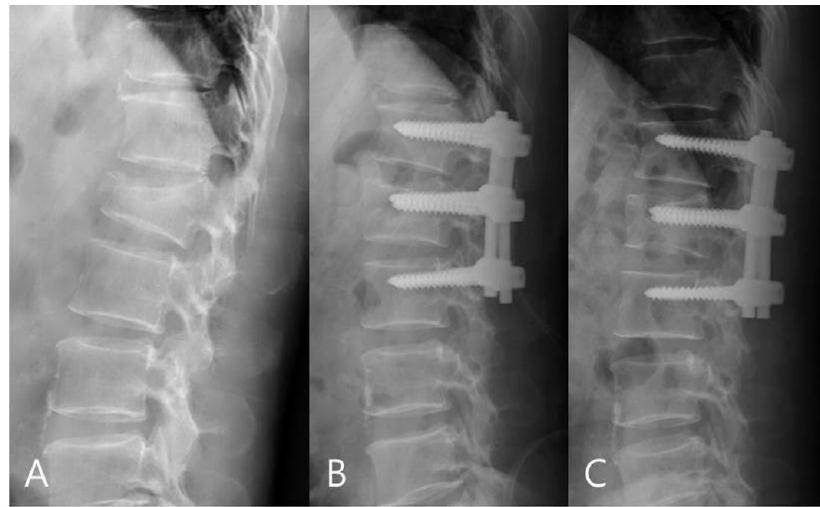
Figure 3. ( A ) 58-year-old male patient with L1 burst fracture was treated by mono-axial pedicle screw fixation. ( B ) Postoperative and ( C ) final follow-up imaging show good correction and no correction loss.